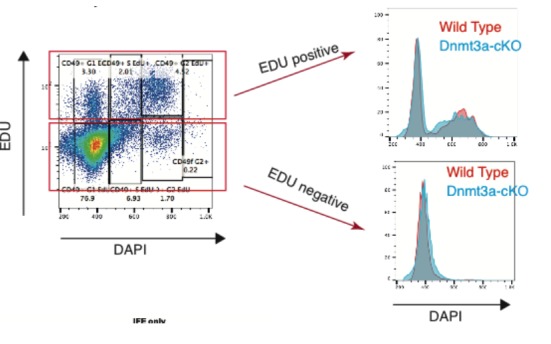
DOI:
http://dx.doi.org/10.7554/eLife.21697.033